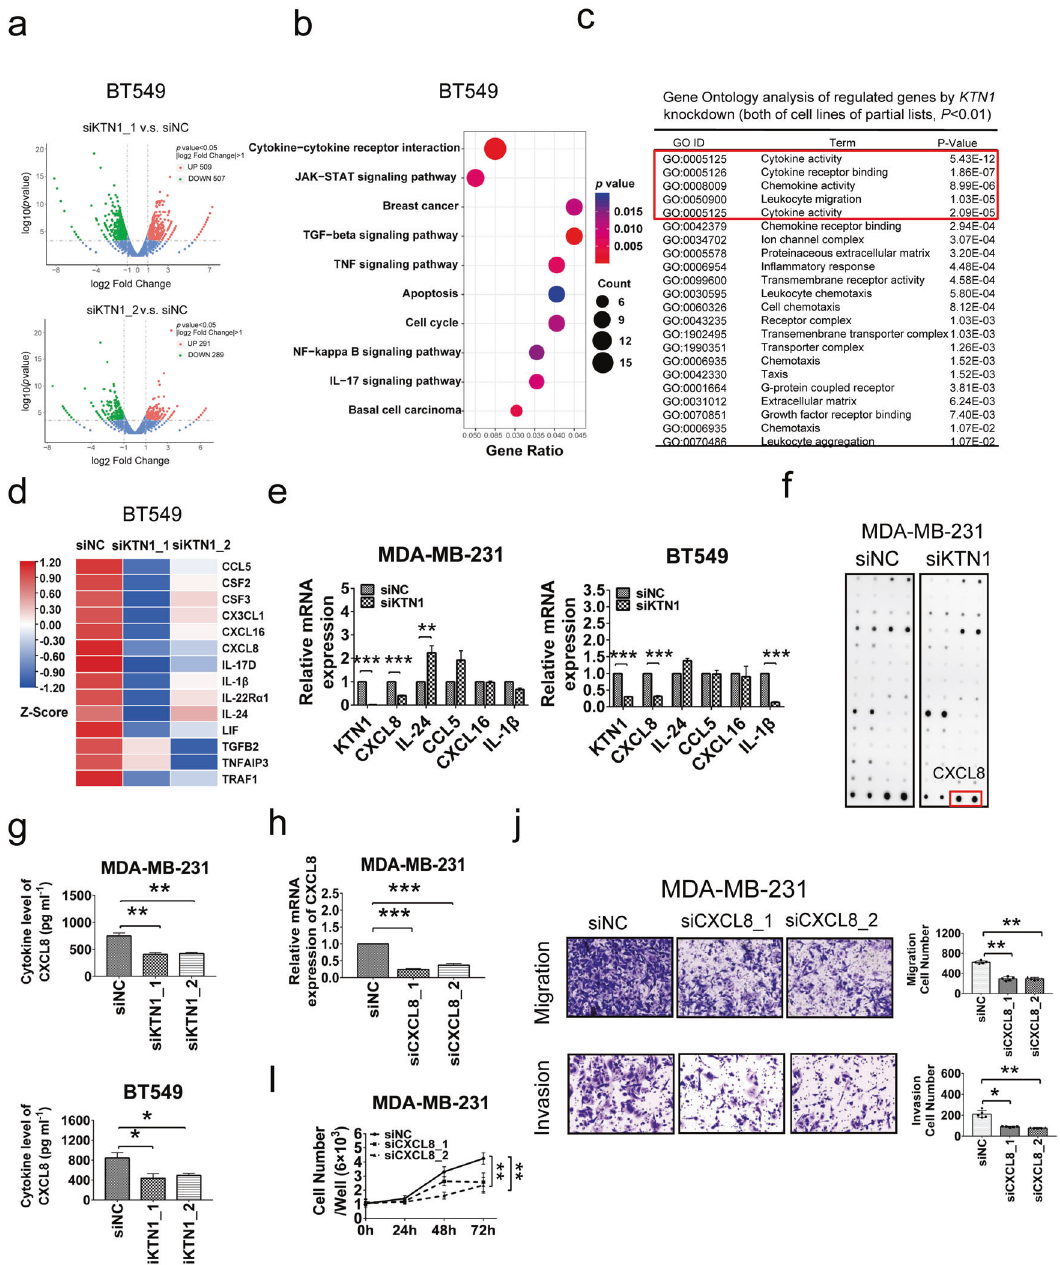
Fig. 3 High-throughput transcriptome sequencing analysis of KTN1-regulated downstream gene pro fi le in TNBC cells. a Total RNAs were isolated from BT549 cells treated with control oligos and KTN1 siRNA oligos and subjected to RNA-seq. Up- and down-regulated genes were shown by volcano plot. b Representative differential signaling pathways were highlighted by KEGG pathway analysis in BT549 cells. c Representative Gene Ontology analysis of differentially expressed genes. BP: biological process; MF: molecular function; CC: cellular component; d A heat map analysis of representative differential cytokine genes in BT549 cells treated by KTN1 siRNA oligos compared with control oligos. e Identi fi cation of KTN1 and top six down-regulated genes in siKTN1 oligos-treated cells. f Cytokine antibody arrays pro fi ling of cytokine secretions in the supernatant of MDA-MB-231 cells with control oligos or KTN1 siRNA oligos. g ELISA assay on the secretion of CXCL8 in MDA-MB-231 cells and BT549 cells transfected with KTN1 siRNA oligos compared with control oligos. h QRT-PCR analysis of mRNA expression of CXCL8 in MDA-MB-231 cells transfected with CXCL8 siRNA oligos compared with control oligos. i CXCL8 knockdown inhibited MDA-MB-231 cell proliferation at 0 h, 24 h, 48 h, and 72 h by CCK-8 assay. j CXCL8 knockdown inhibited cell migration and invasion by Transwell assay. Each experiment was performed in triplicate and data a represented as mean ± s.d. One-Way ANOVA and Dunnett ’ s multiple comparison test were used to analyze the data (* P < 0.05, ** P < 0.01, *** P < 0.001). Scale bars, 100